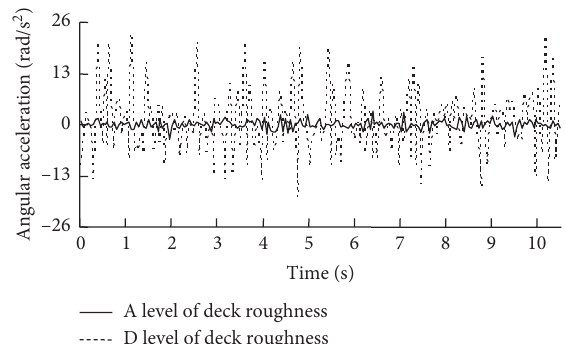
Figure 10: The time-history curves of rolling vibration accelera- tions of the vehicle